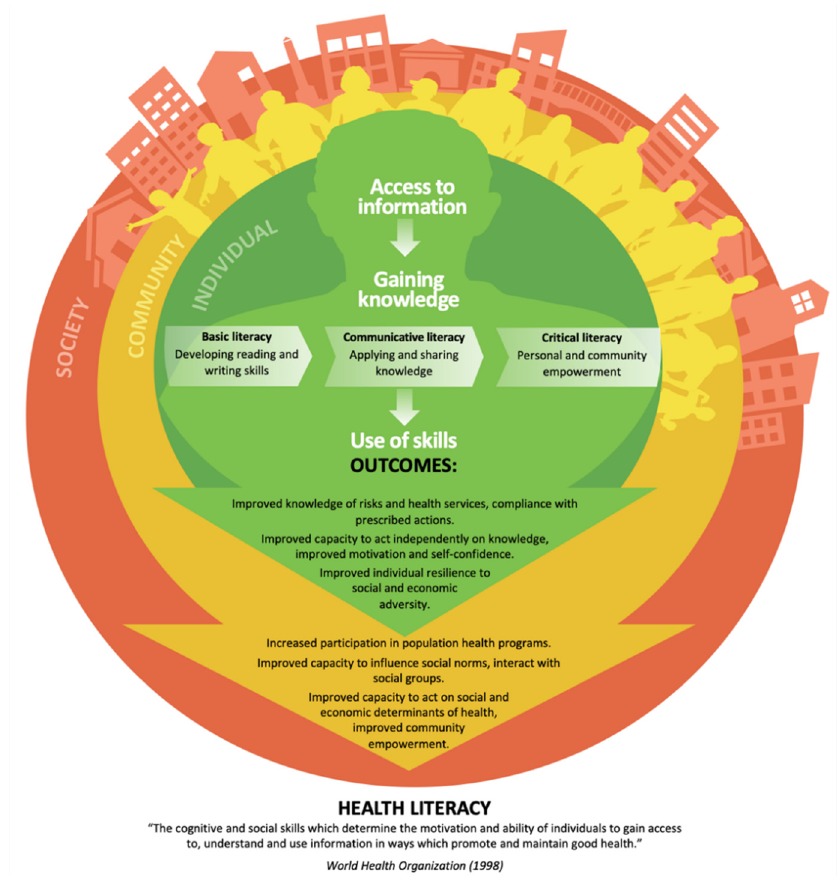
Figure 3. The different levels of Health Literacy. Figure developed using information adapted from Nutbeam